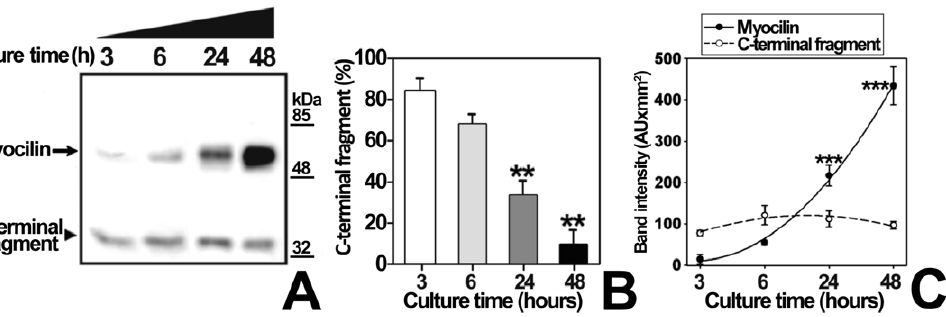
Figure 7. Time-course analysis of myocilin proteolytical processing in bicarbonate-free medium. (A) HEK-293T cells (200000 cells/plate) were transfected with a cDNA construct encoding myocilin-myc. After transfection cells were cultured in bicarbonate-free HEPES buffered medium, pH 7.1, as indicated in Fig. 6, and aliquots of the medium were collected at 3, 6, 24 and 48 h. Recombinant myocilin was detected in the culture medium by 10% polyacrylamide SDS-PAGE and Western blot using an anti-myc monoclonal antibody. Equal amount of total protein was loaded into each well. (B) Quantitation by densitometry of the C-terminal fragment detected in A. Values represent the proportion of this myocilin fragment, expressed as indicated in Fig. 1B. (C) Densitometric quantitation of the full-length and C-terminal myocilin fragment detected in A. Error bars correspond to the SD of three independent experiments carried out in triplicate. Asterisks indicate statistical significance compared to control: p , 0.01 (**); p , 0.001 (***). One-way ANOVA followed by Tukey multiple-comparison test.